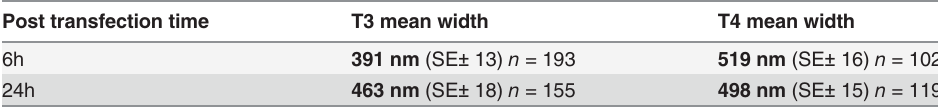
Table 2. Mean T3 and T4 width after expression in U-2 OS cells.